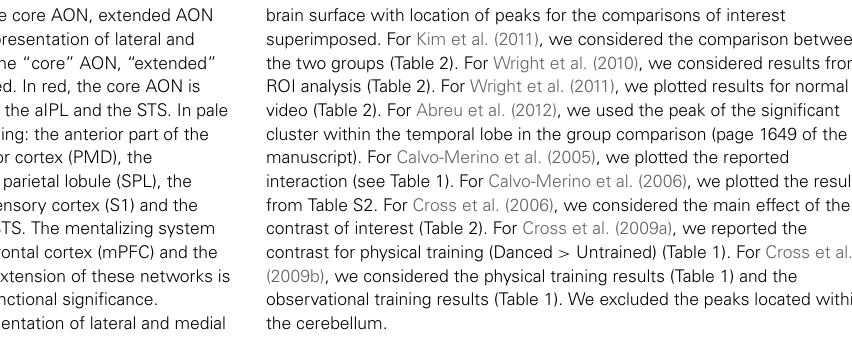
brain surface with location of peaks for the comparisons of interest superimposed. For Kim et al. (2011), we considered the comparison between the two groups (Table 2). For Wright et al. (2010), we considered results from ROI analysis (Table 2). For Wright et al. (2011), we plotted results for normal video (Table 2). For Abreu et al. (2012), we used the peak of the significant cluster within the temporal lobe in the group comparison (page 1649 of the manuscript). For Calvo-Merino et al. (2005), we plotted the reported interaction (see Table 1). For Calvo-Merino et al. (2006), we plotted the results from Table S2. For Cross et al. (2006), we considered the main effect of the contrast of interest (Table 2). For Cross et al. (2009a), we reported the contrast for physical training (Danced > Untrained) (Table 1). For Cross et al. (2009b), we considered the physical training results (Table 1) and the observational training results (Table 1). We excluded the peaks located within the